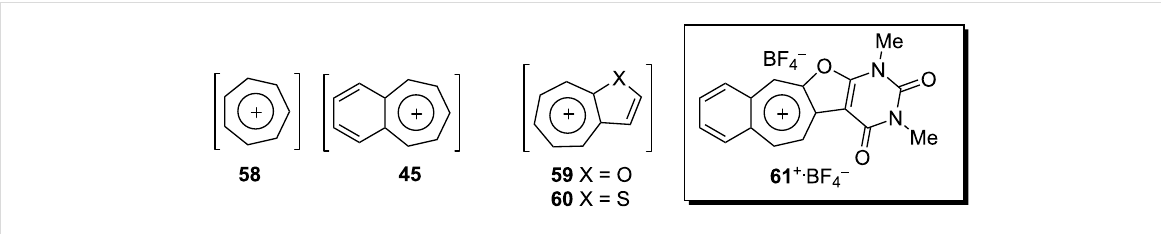
Figure 3: Some cycloheptatrienylium cations.